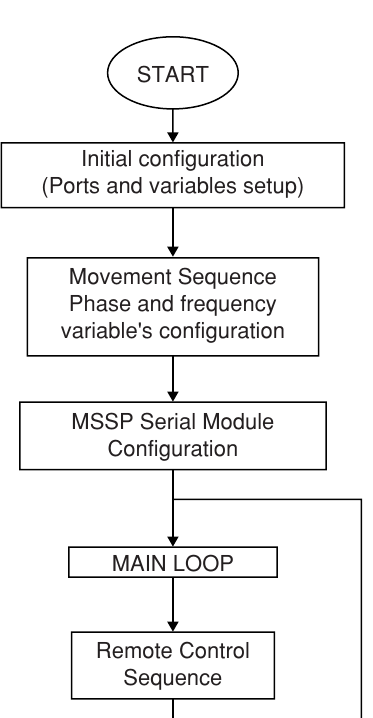
Figure 4 Master module principle